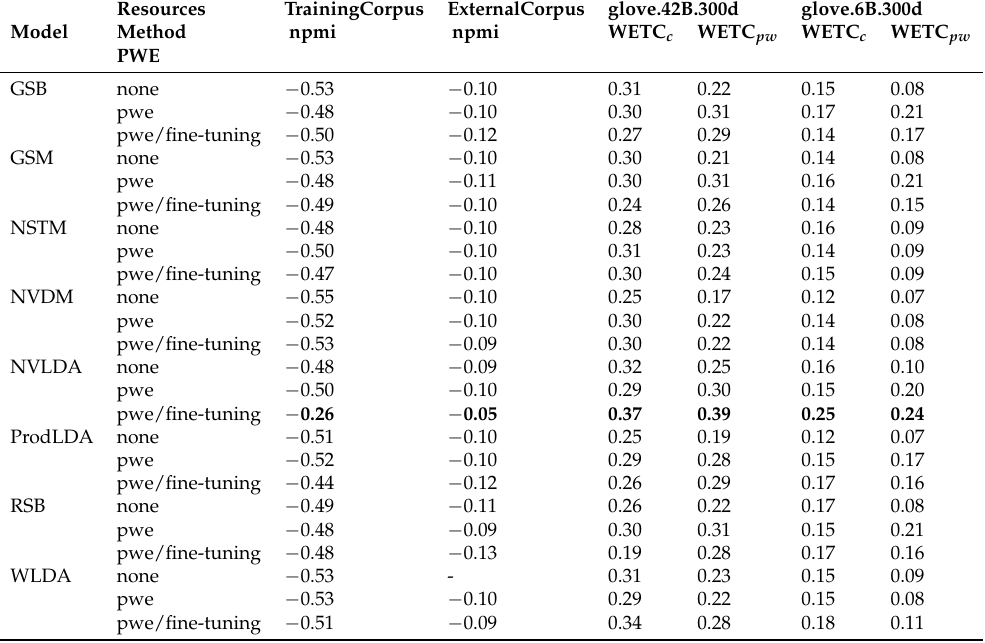
Table 11. Topic Coherence on